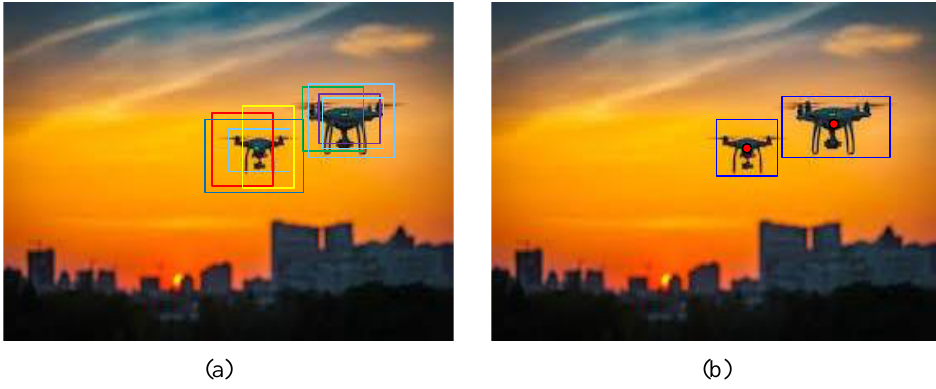
Figure 2. ( a ) Standard anchor-based detection. ( b ) Center point-based